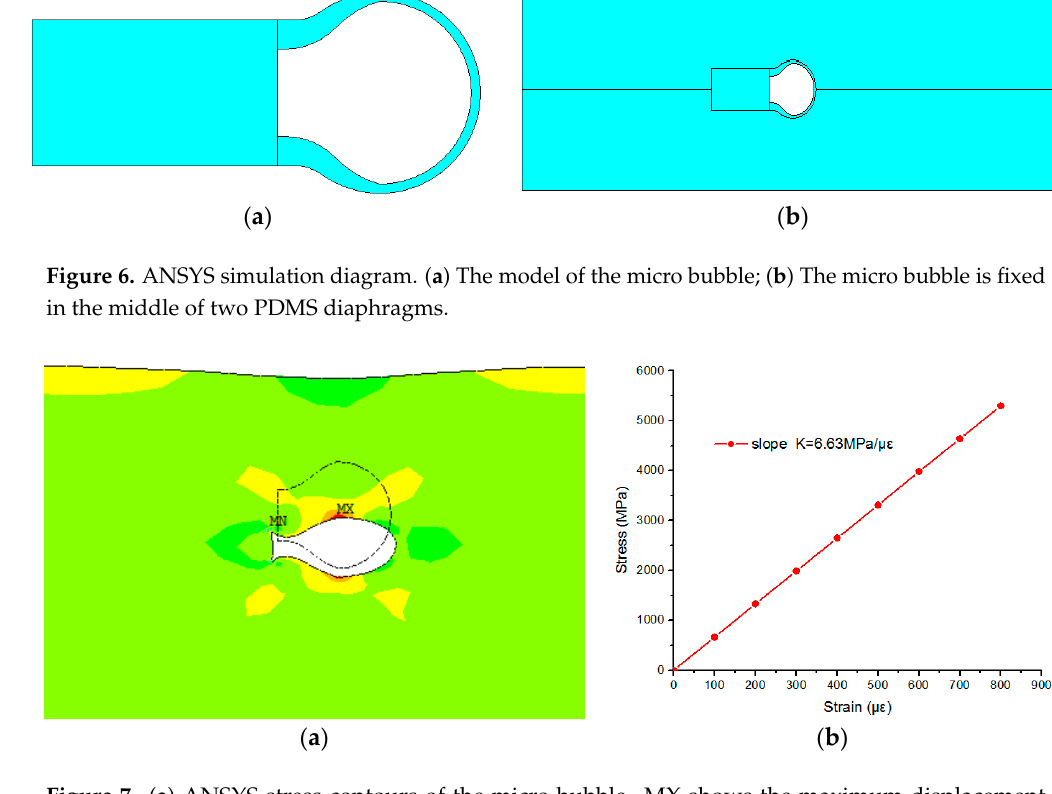
Figure 7. ( a ) ANSYS stress contours of the micro bubble. MX shows the maximum displacement variation, whereas MN is the minimum displacement variation; ( b ) Calculated stress of air bubble versus the applied strain.